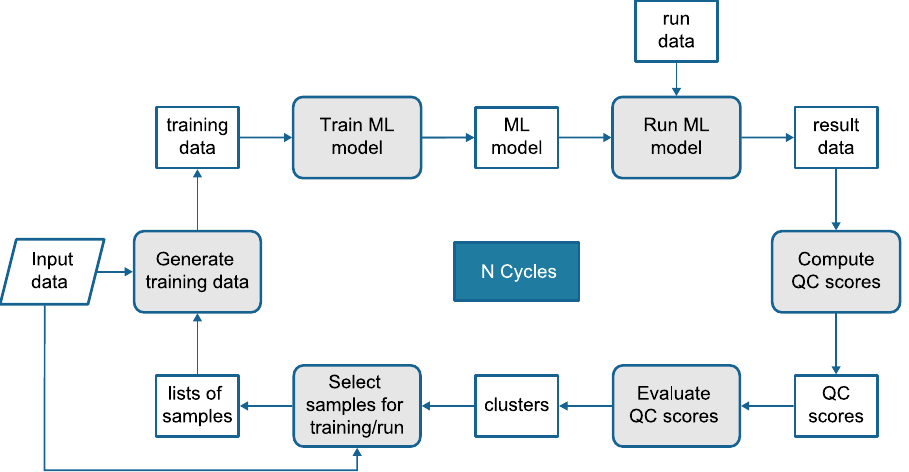
Figure 1. Geocycles is composed of machine learning tasks, score computation and evaluation, and sample